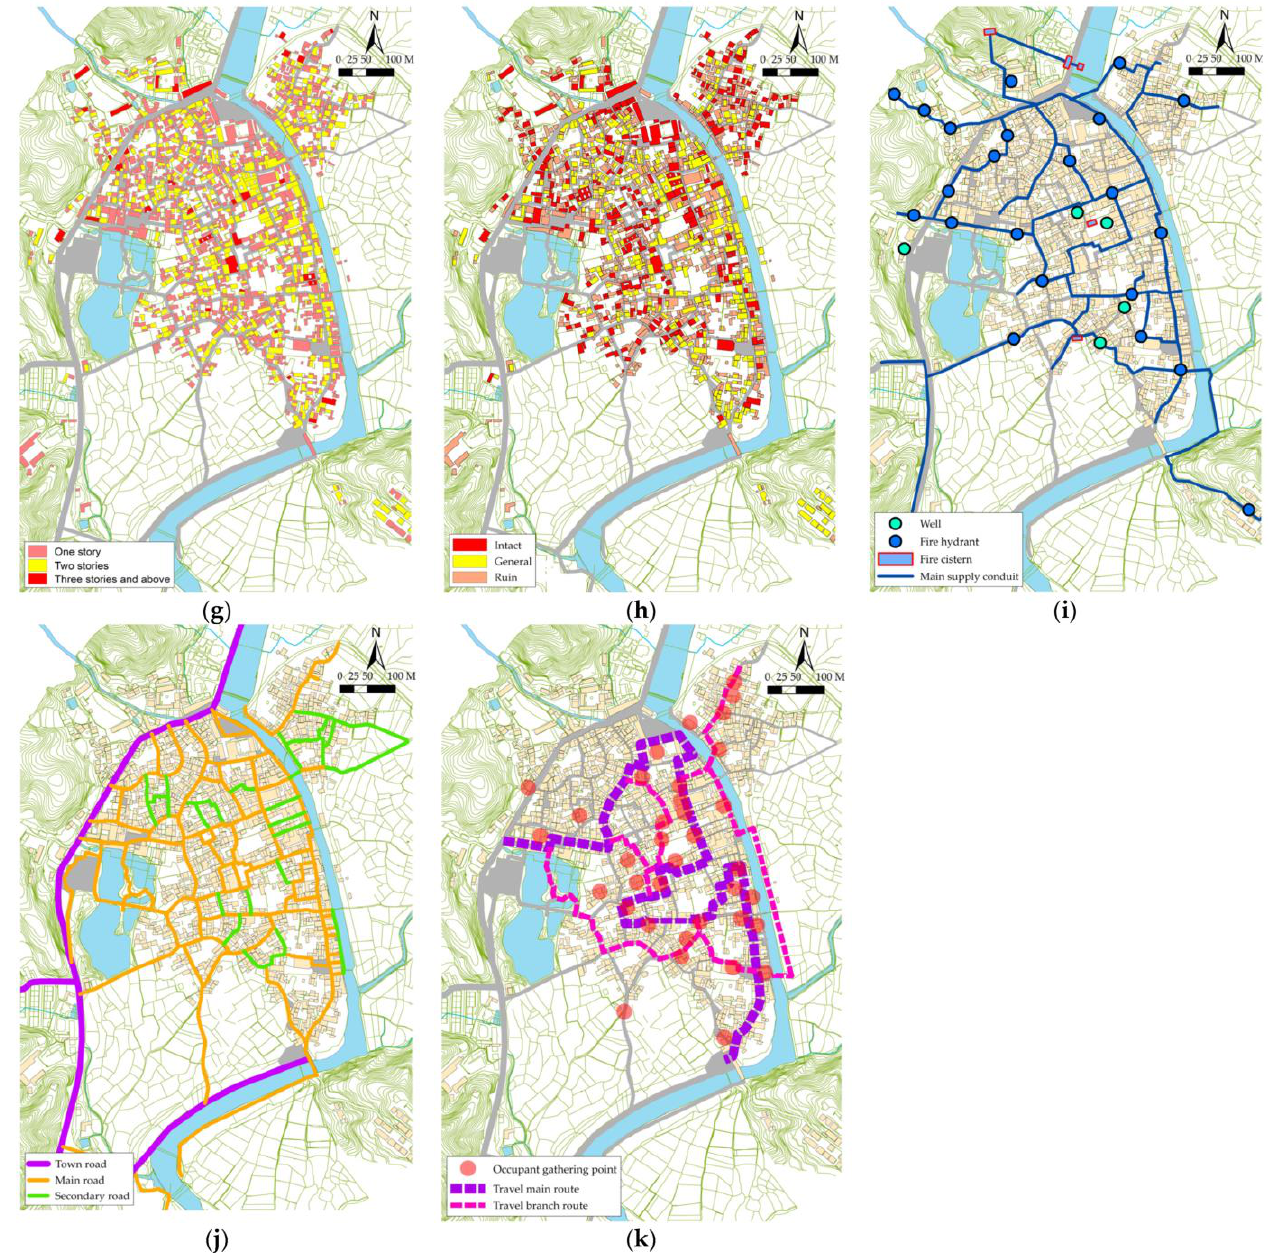
Figure 10. Fire risk assessment vector data of Chengkan Village. ( a ) The plan for Chengkan Village; ( b ) classification of protection levels of cultural relic; ( c ) classification of cultural relic protection elements; ( d ) environmental sanitation distribution map; ( e ) building renovation mode diagram; ( f ) wire and cable distribution diagram; ( g ) building height distribution diagram; ( h ) building quality distribution diagram; ( i ) layout of water supply and fire protection; ( j ) road traffic distribution map; ( k ) travel route map.